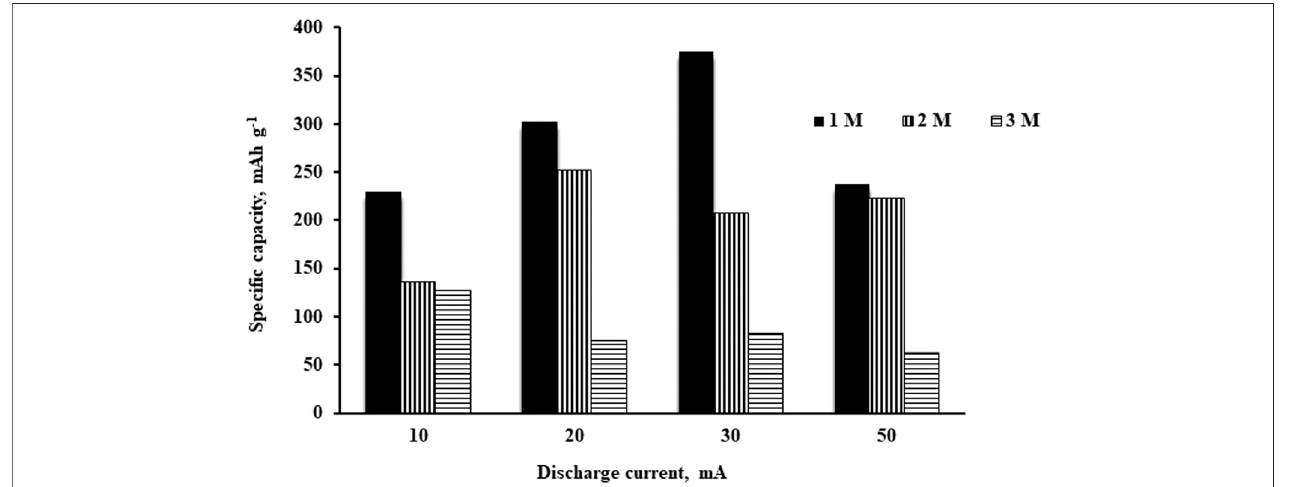
FIGURE 6 | Speci fi c discharge capacity of various concentrations and discharge